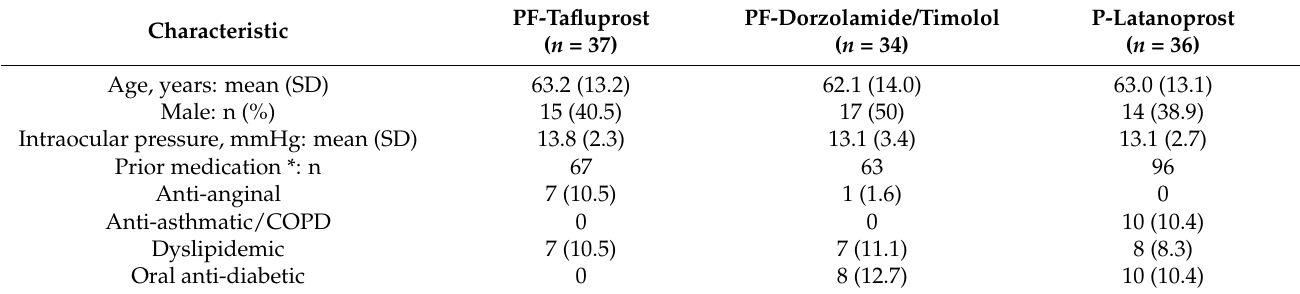
Table 1. Patient demographics at baseline in the FAS1 ( n = 107).